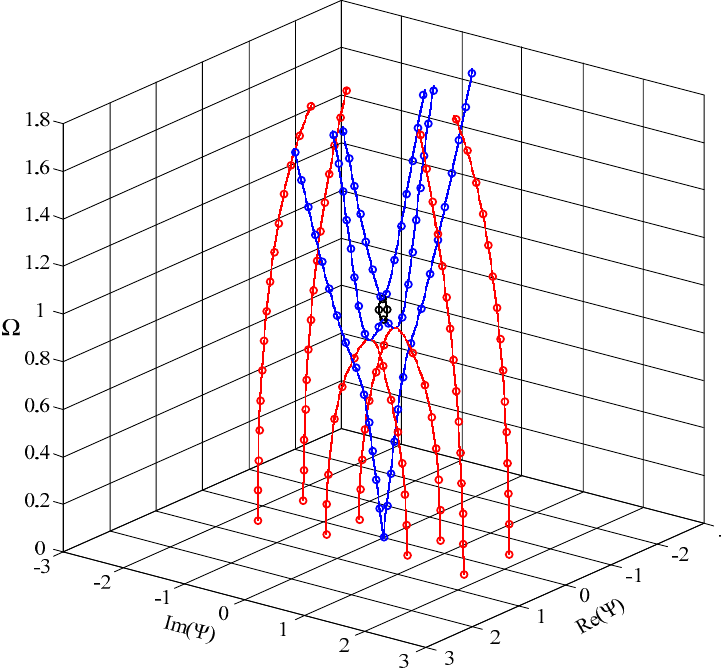
Figure 2. Dispersion curves of Lamb wave in a steel plate; hollow dots-our results, solid lines-literature results from the spectral collocation method; real branch in blue, purely imaginary branch in black, complex branch in red.